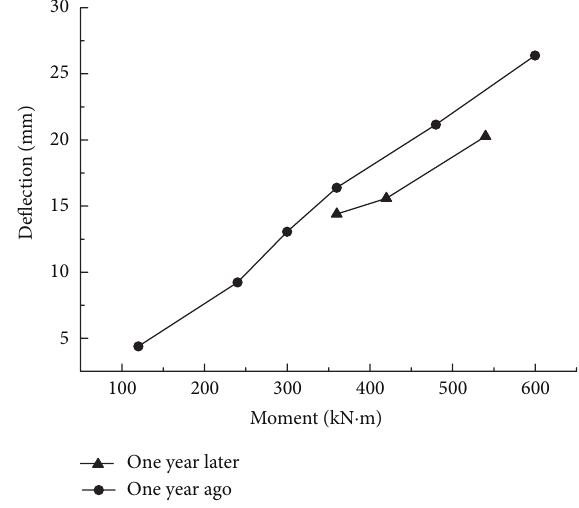
Figure 19: The relationship curve between midspan deflection and the bending moment for Side-B during one